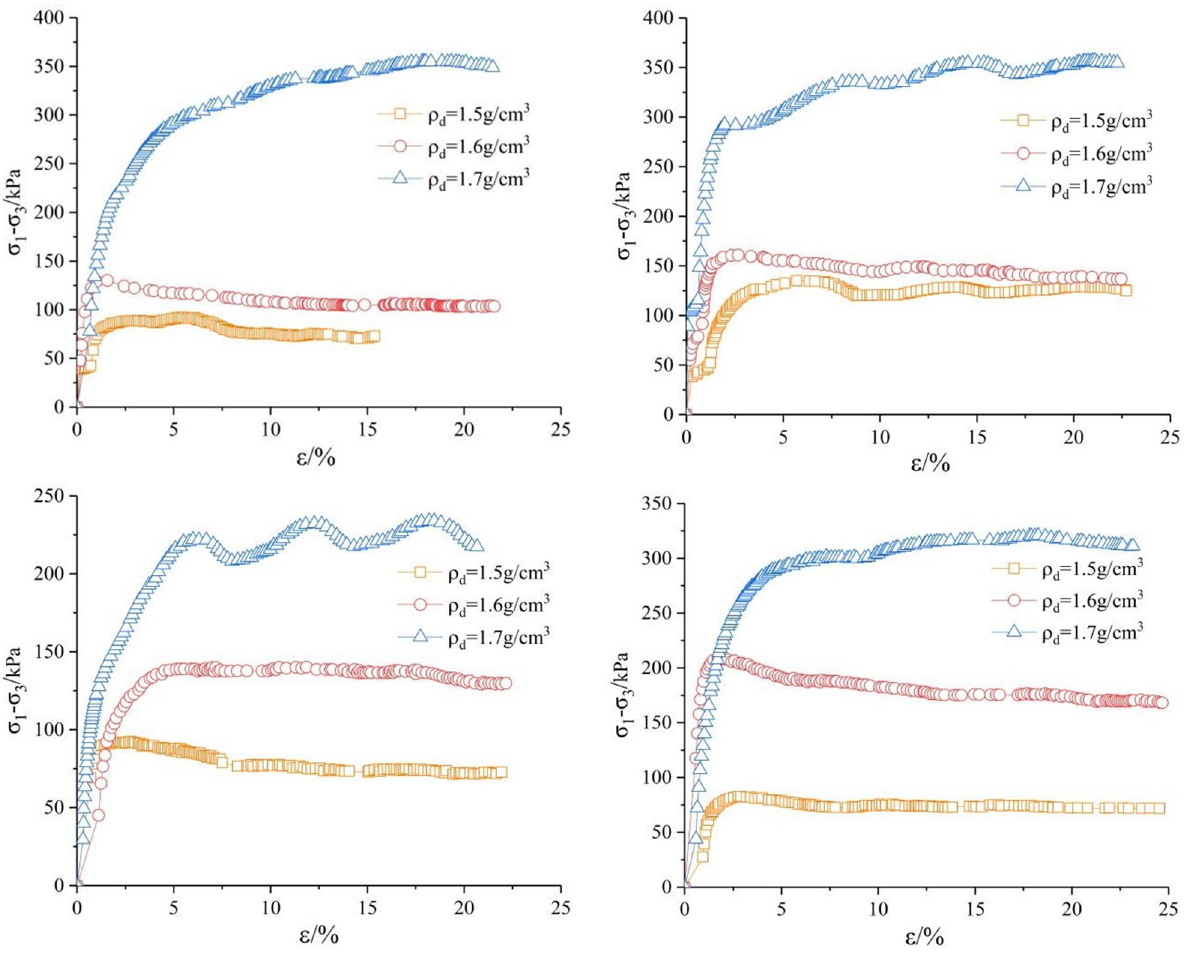
Fig 3. σ curve under confining pressure of 100 kPa . (a) Shear rate v = 0.04 mm/min . (b) Shear rate v = 0.08 mm/min. (c) Shear rate v = 0.16 1 -σ 3 ~ ε mm/min . (d) Shear rate v = 0.4 mm/min .